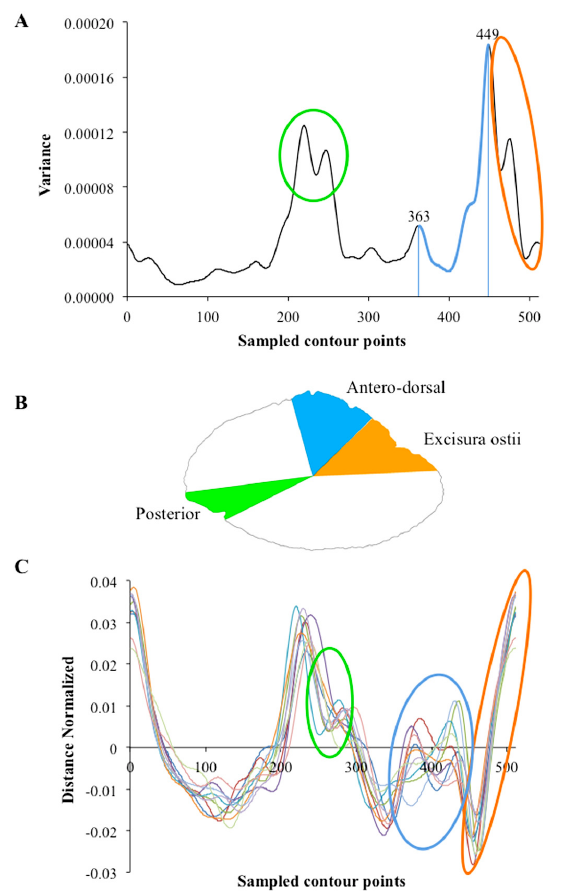
Fig . 6. – Signals of wavelet 5 from the otoliths of snappers from the Persian Gulf. Colours show the similarities between signals. Fig . 7. — Graphics indicating zones with higher variability in wave- let 5. (A) variance for all species, (B) otolith contour, (C) wavelet 5 for each